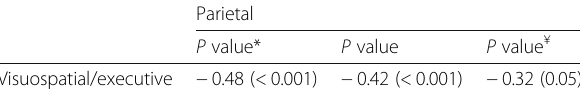
Table 7 Correlations between parietal CMBs and cognitive indices after controlling different parameters